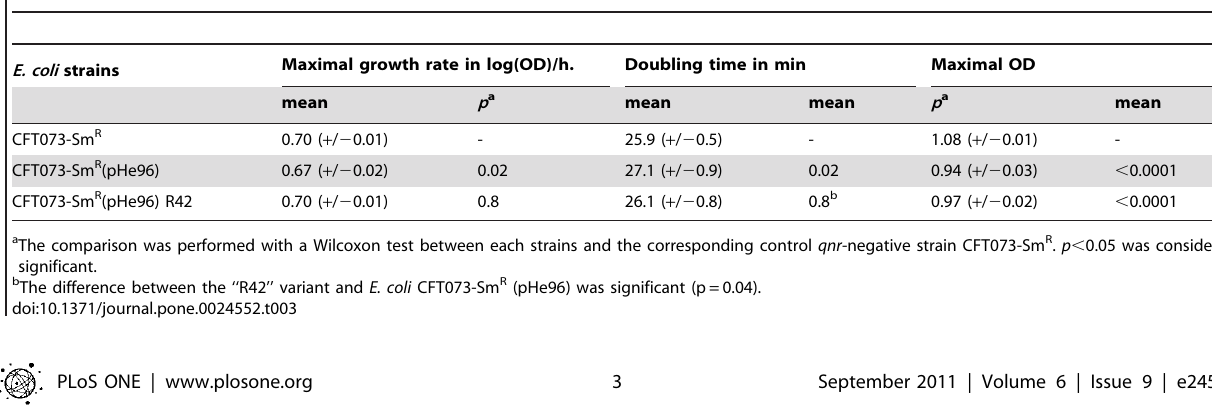
Table 3. In vitro growth parameters for the strains of the second isogenic system based on acquisition of the multidrug resistant qnrA3 -positive plasmid